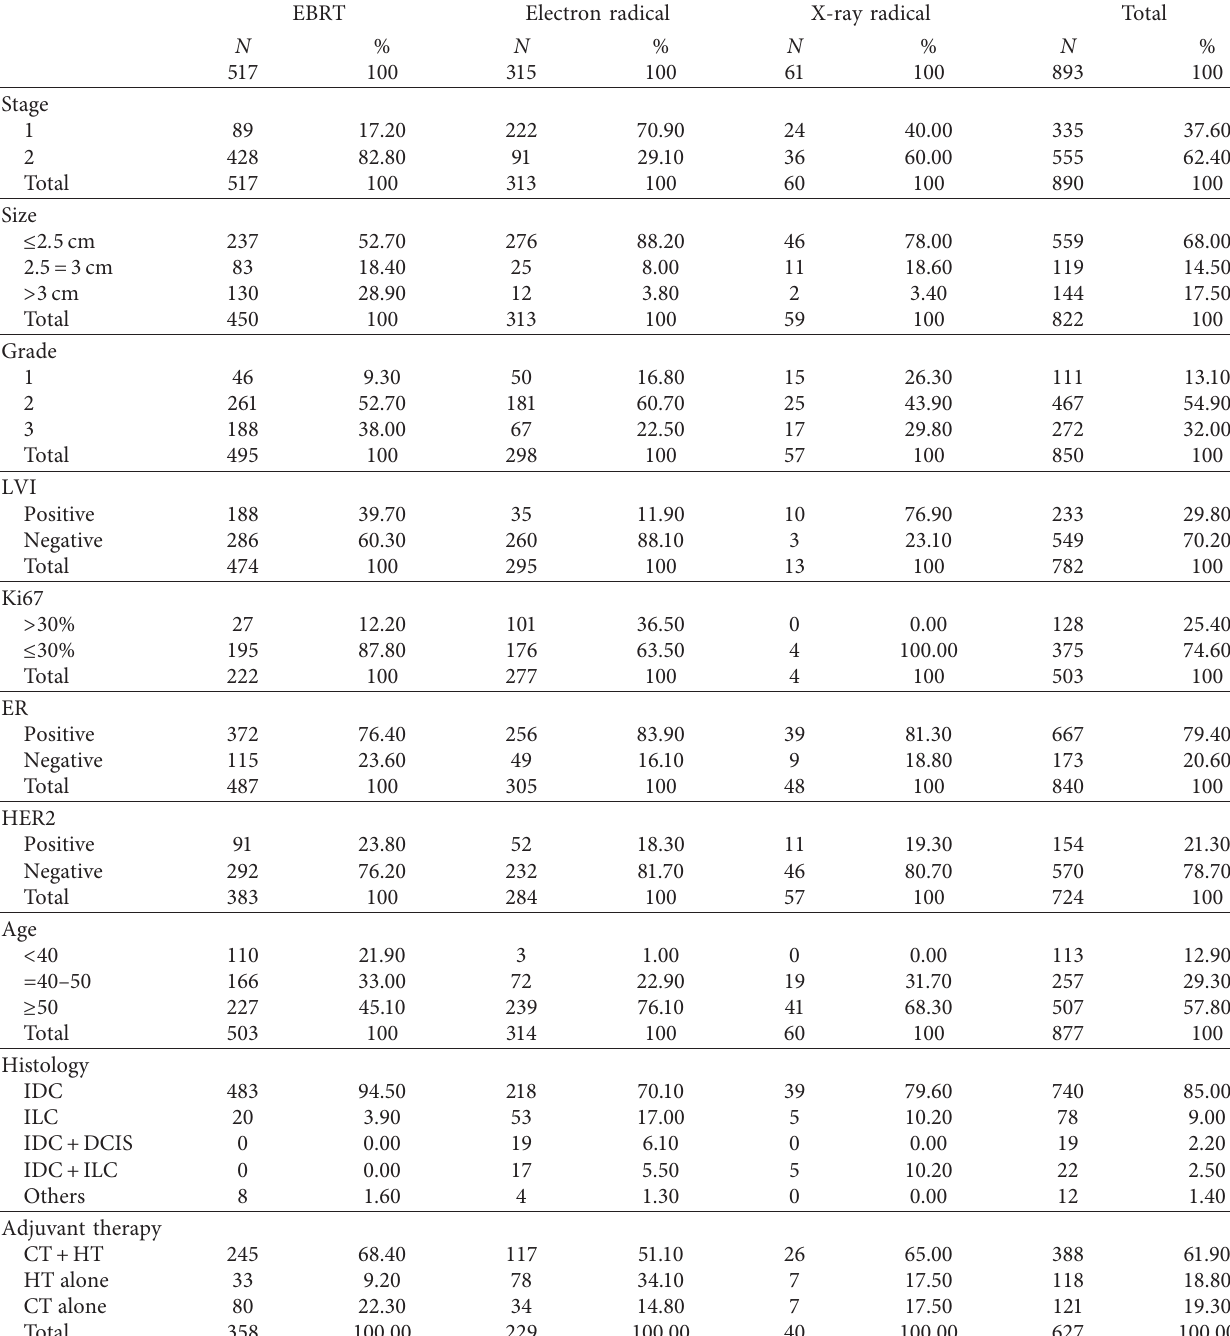
Table 4: Clinical, pathologic, and treatment-related characteristics of the EBRT and radical-IORT groups.